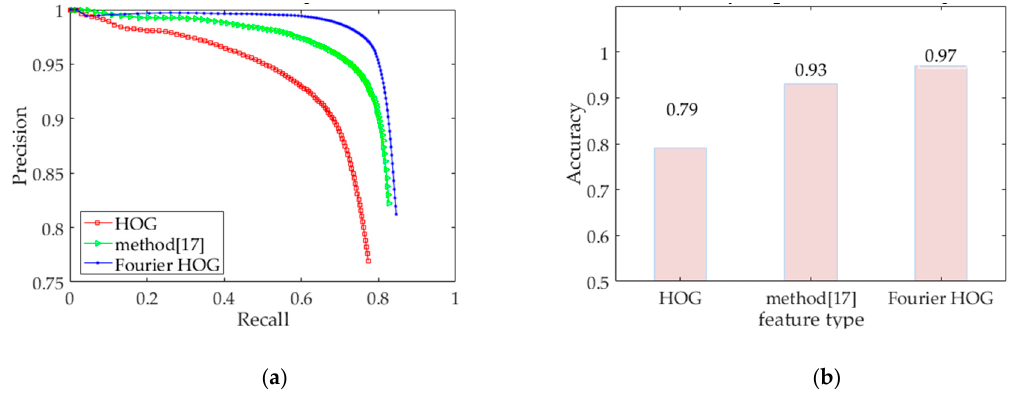
Figure 13. PR (precision-recall) curve and classification accuracy for di ff erent types of feature. Figure 13 . PR (precision-recall) curve and classification accuracy for different types of feature. ( a ) ( a ) Precision-recall curve. ( b ) Classification accuracy. Precision-recall curve. ( b ) Classification accuracy.